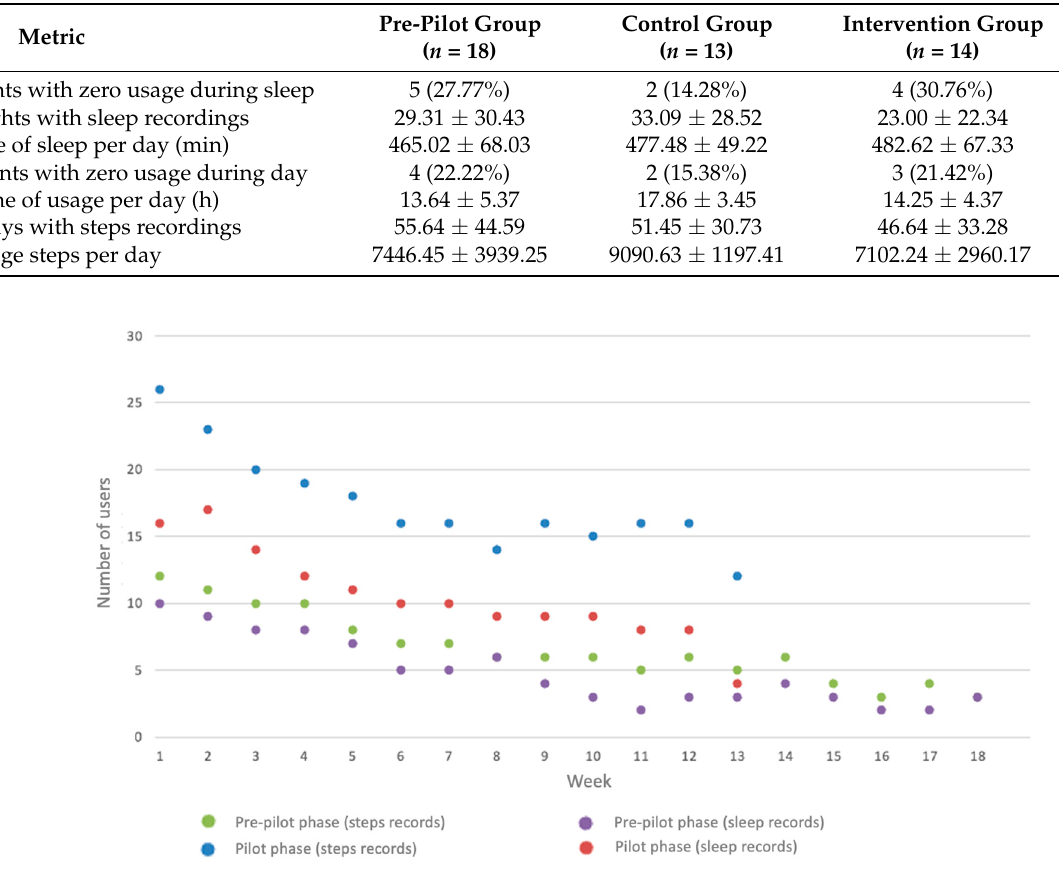
Table 4. Usage metrics of the physical activity tracker.